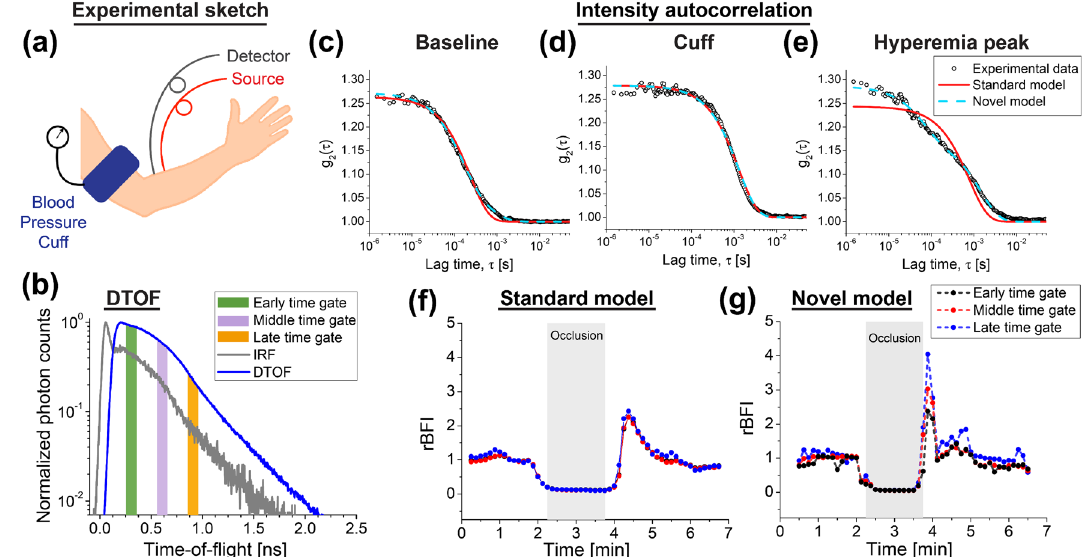
Figure 4. In vivo cuff occlusion challenge in human forearm. ( a ) Experimental sketch. ( b ) Representative DTOF, showing the time gates, used for estimating the relative BFI trends ( f , g ). ( c – e ) Representative intensity ACFs of different stages of the measurement. At the baseline, intensity ACF decorrelates much faster ( c ) than at the cuff occlusion stage ( d ). Right after the cuff is released, the intensity ACF is composed of the two ACFs that decorrelate at different rates ( e ). The novel model depicts the depth-dependent reactive hyperemia ( g ), while conventional TD-DCS model does not ( f